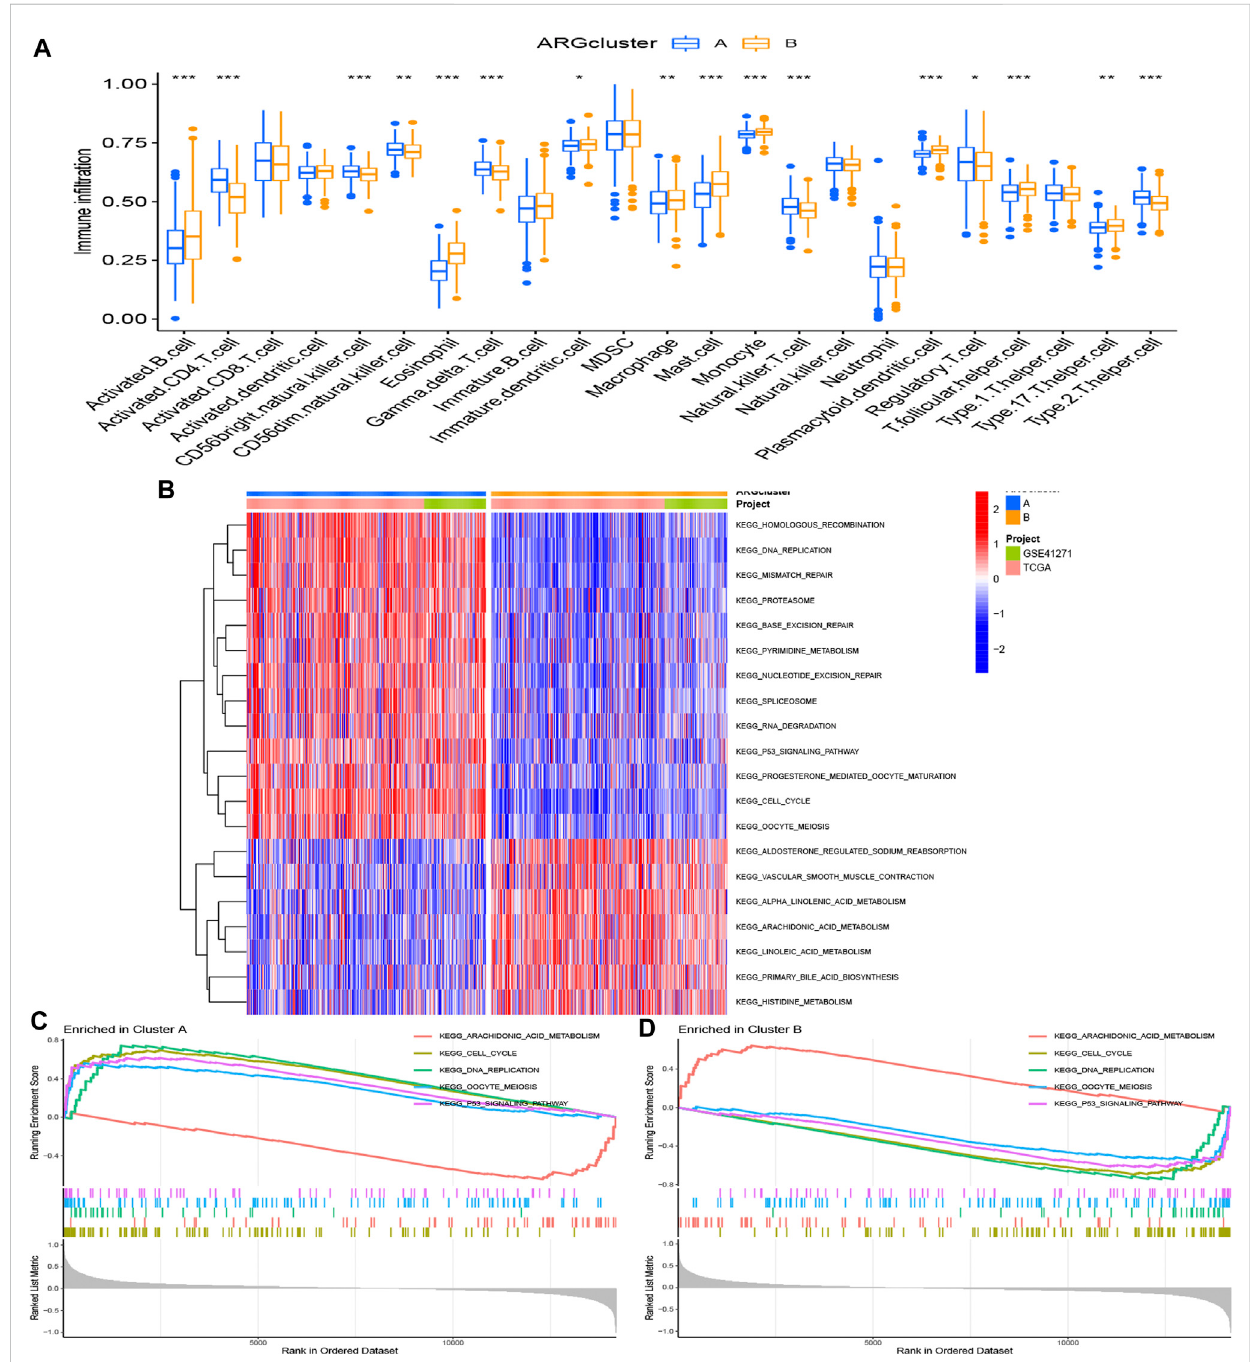
FIGURE 3 Gene set enrichment analysis. (A) Expression differences of immune cell in fi ltration between ARG cluster A and (B) * p < 0.05, ** p < 0.01, and *** p < 0.001. (B – D) The KEGG enrichment analysis for the anoikis-related differentially expressed genes uncovered potential mechanism on the occurrence and development of the two patterns. Construction of cuproptosis-related risk model. (A) The point of minimum error was picked out by vertical dotted line based on LASSO cross validation. (B) Dynamic process diagram of Lasso fi ltering variables.